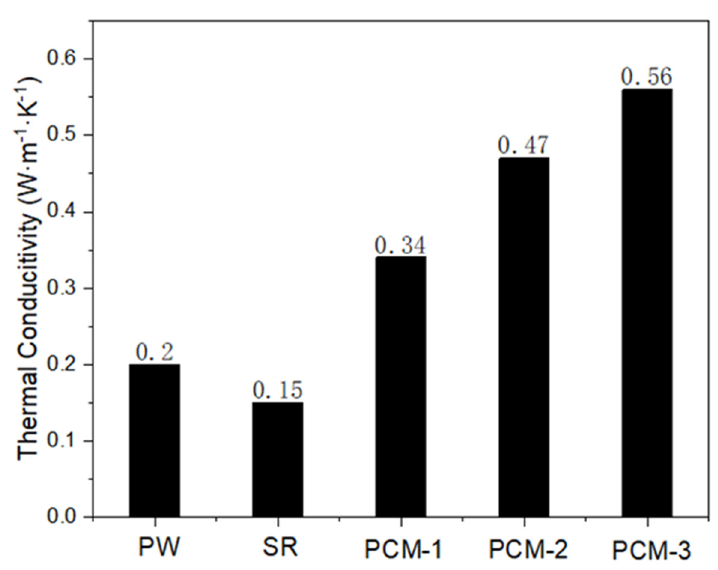
ffi cients of PW, SR and EG / PW / SR Figure 9. Thermal conductivity coefficients of PW, SR and EG/PW/SR composites. Figure 9. Thermal conductivity coe